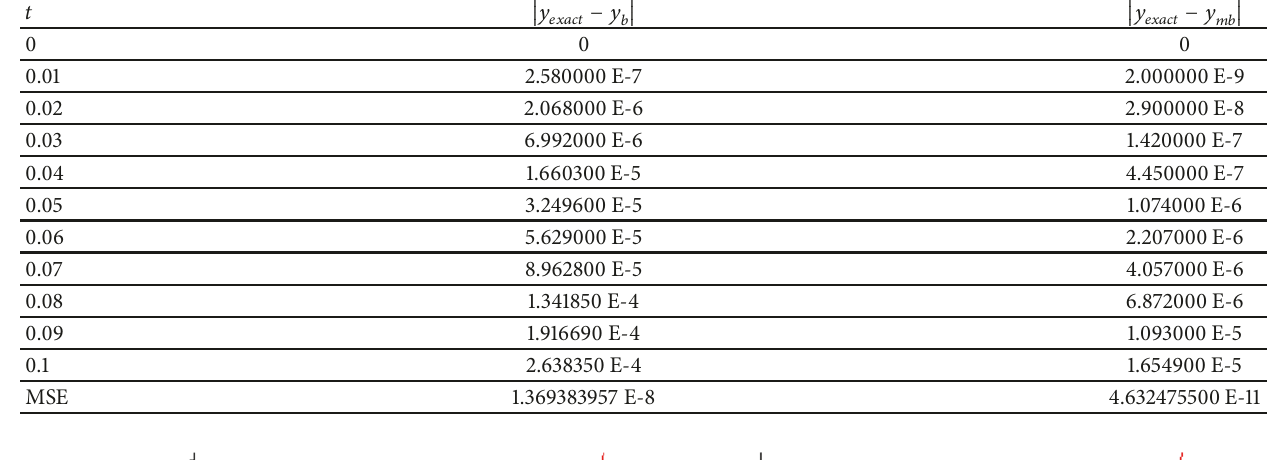
Table 1: Comparison of absolute errors using 𝑦 6 when m=v=6 and k=2.